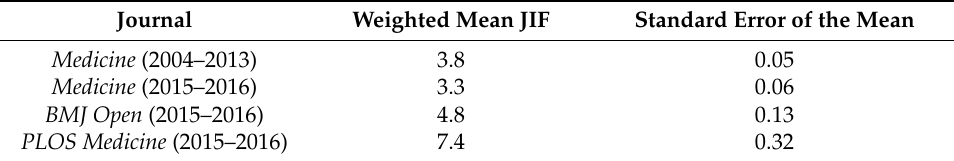
Table 7. Weighted mean JIFs of citing journals.